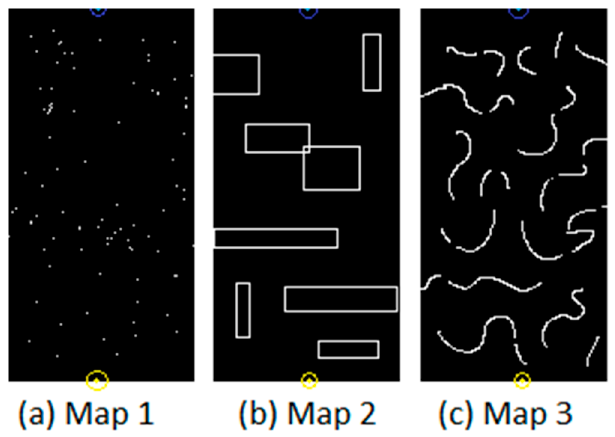
Figure 13. Maps used for the tests: ( a ) Forest-like map; ( b ) Buildings-like map; ( c ) Some complex environment.